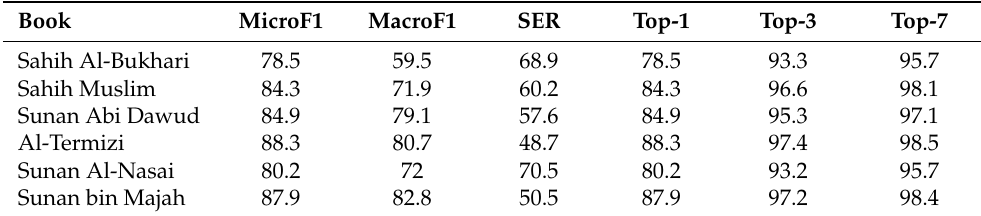
Table 11. Evaluation of TunedAraBERT: Micro, Macro F1, sanad error rate, and Top-k accuracy on each book separately.